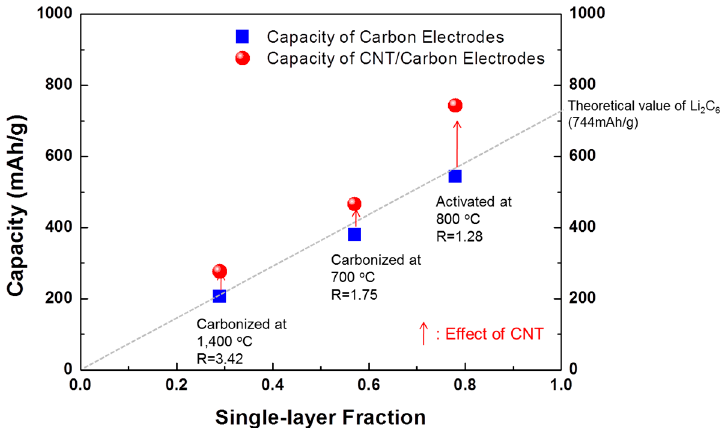
Figure 7. Relationship between the specific capacity and the single-layer fraction of the carbon nanofibers, and the CNT-carbon nanofibers heat-treated under different conditions.